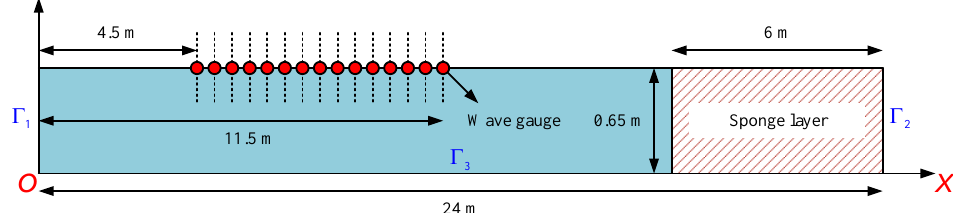
Figure 4. Schematic diagram of the 3D GFDM-based NWF employed for Example